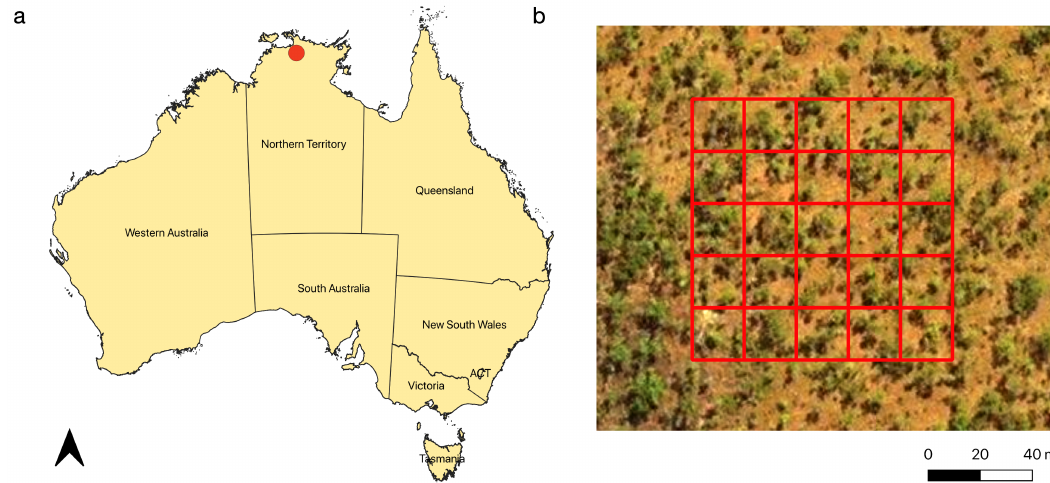
Figure 1. Location of the study site in northern Australia ( a ), and an aerial view of vegetation cover within the 20 × 20 m subplots of the 1 ha study area ( b